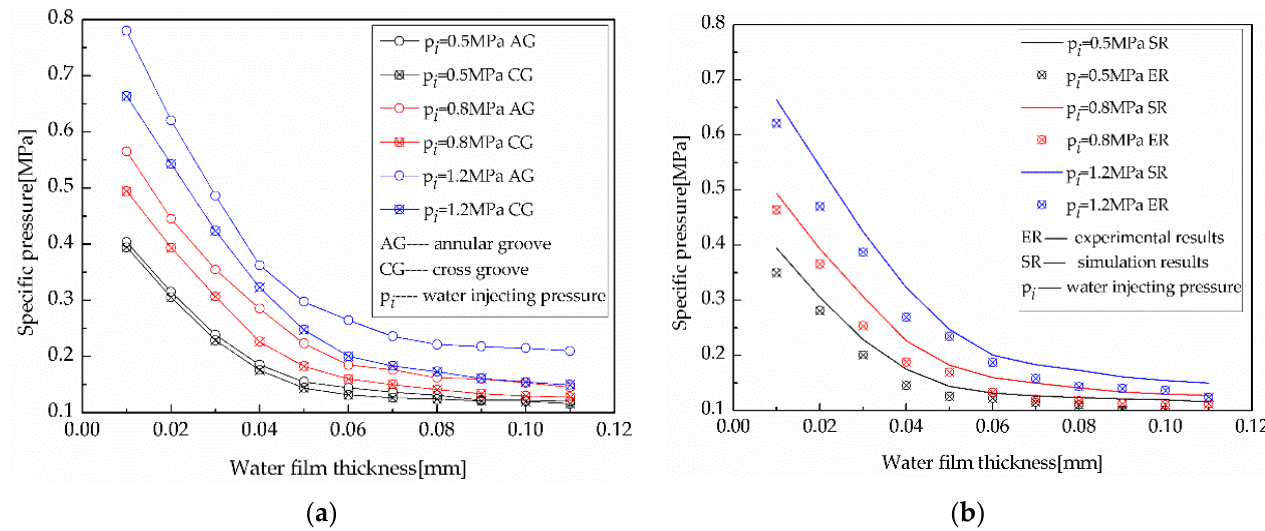
Figure 13. Comparison of the bearing capacity for ( a ) annular groove vs. crossing groove (simulated results), ( b ) crossing groove (simulated results vs. experimental results).